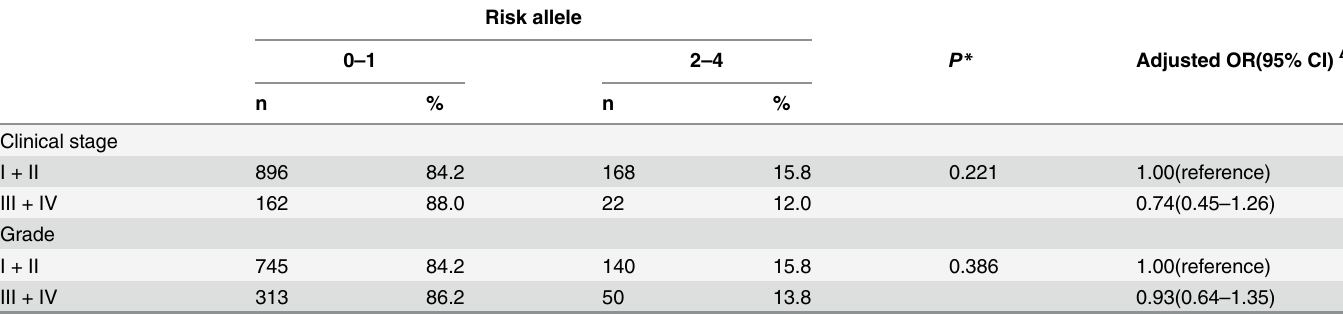
Table 5. Association between Cav-1 and ROCK1 polymorphism and clinicopathologic characteristics of ccRCC.